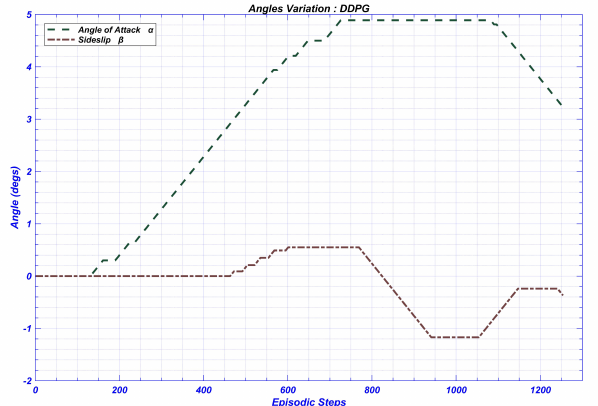
Figure 5. Angles variation of